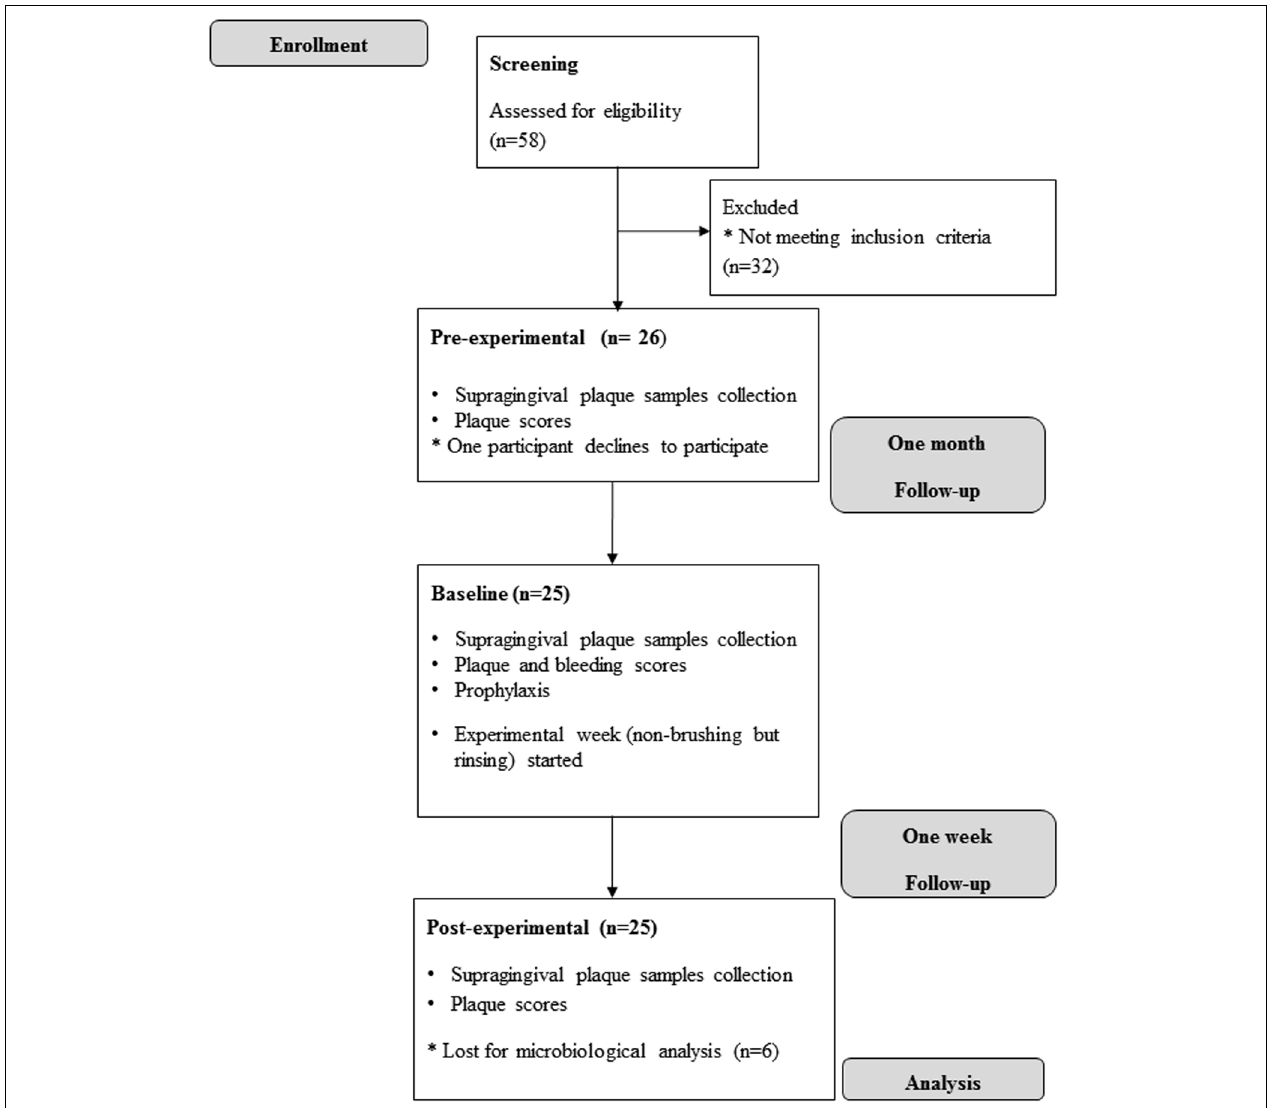
FIGURE 2 | Flow chart and timeline of the pilot clinical study.